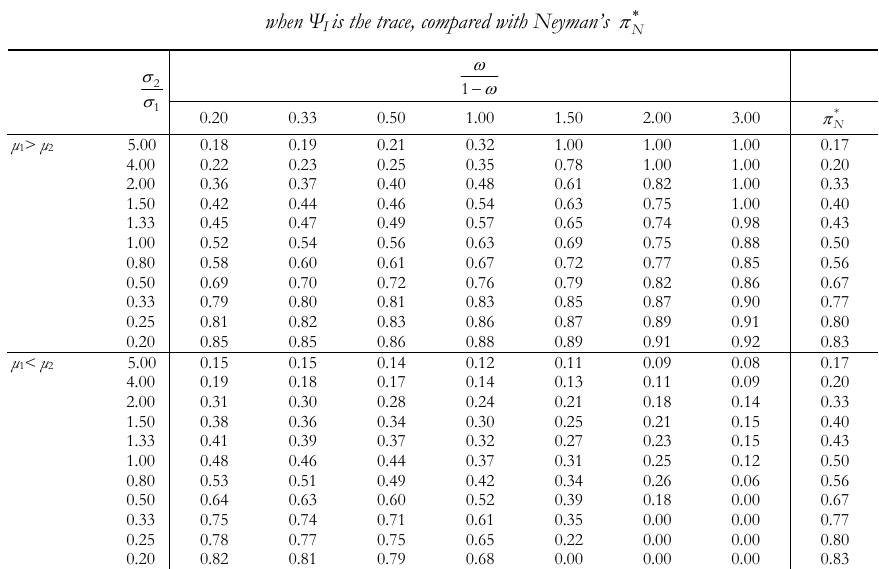
 for different values of  